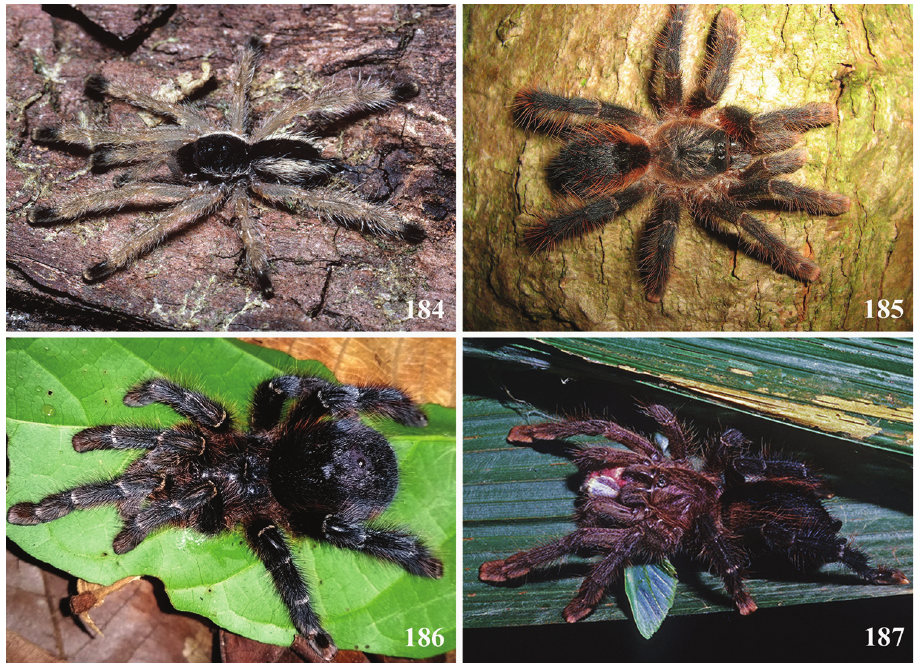
Figures 184–187. Avicularia hirschii Bullmer, Thierer-Lutz & Schmidt, 2006, habitus. 184